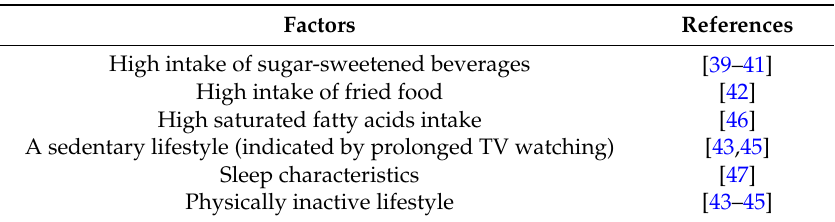
Table 1. Unfavorable lifestyle and dietary factors that may accelerate risk of obesity among individuals genetically at high